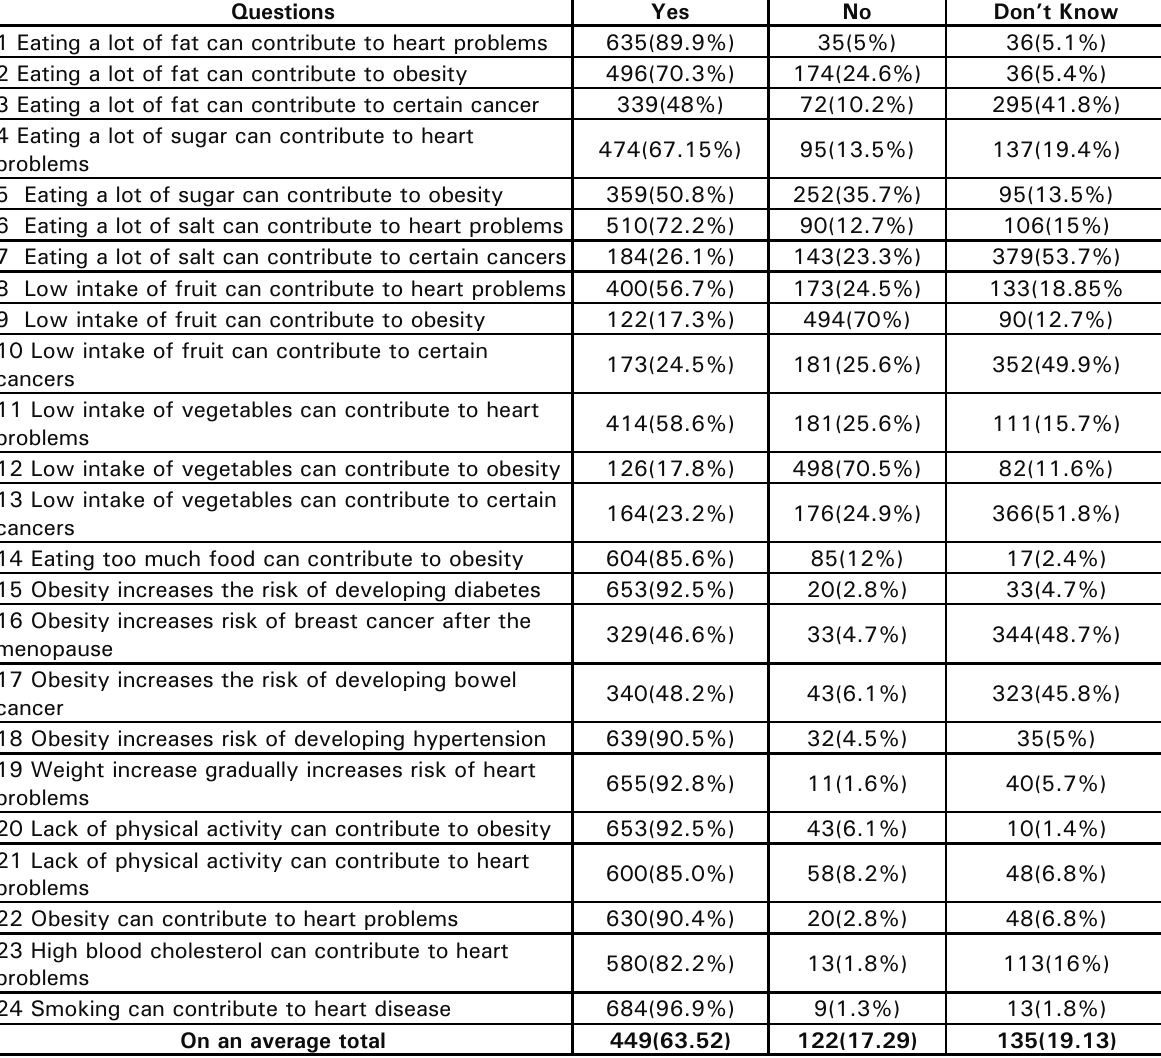
Table 1: Knowledge of the dietary and behavioral-related risk factors of the participants (n=706)